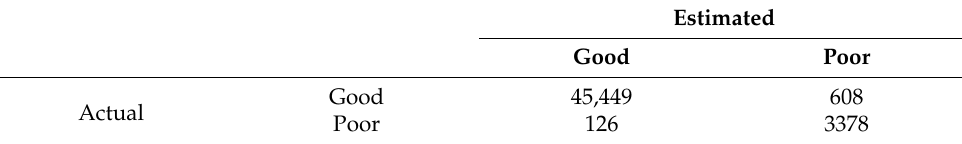
Figure 4. Loss and accuracy of training and validation processes. Red lines mean accuracy and blue lines mean loss. Table 3. Confusion matrix.